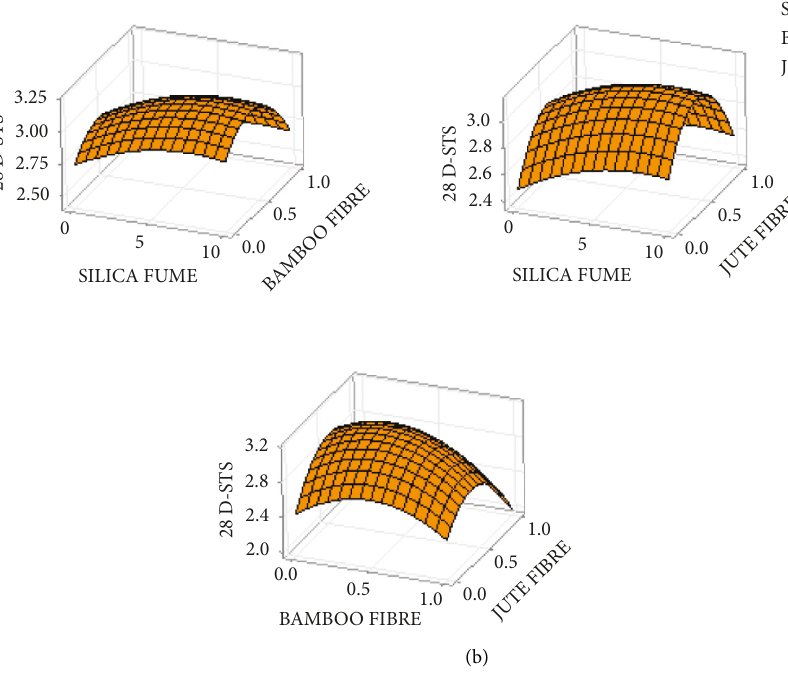
Figure 9: Surface plot for (a) fSTS